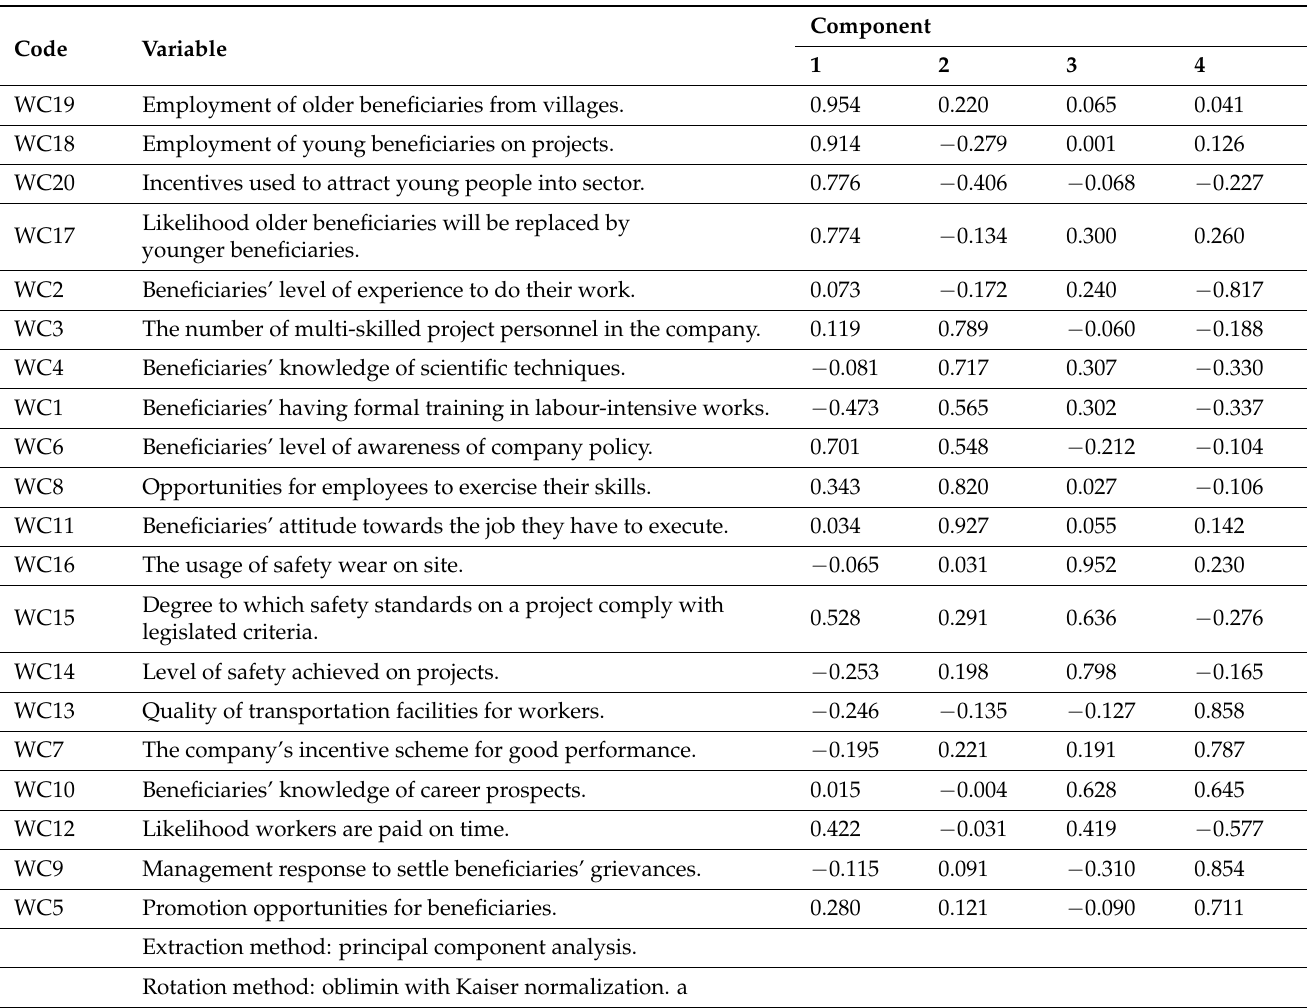
Table 4. Pattern factor loading for worker